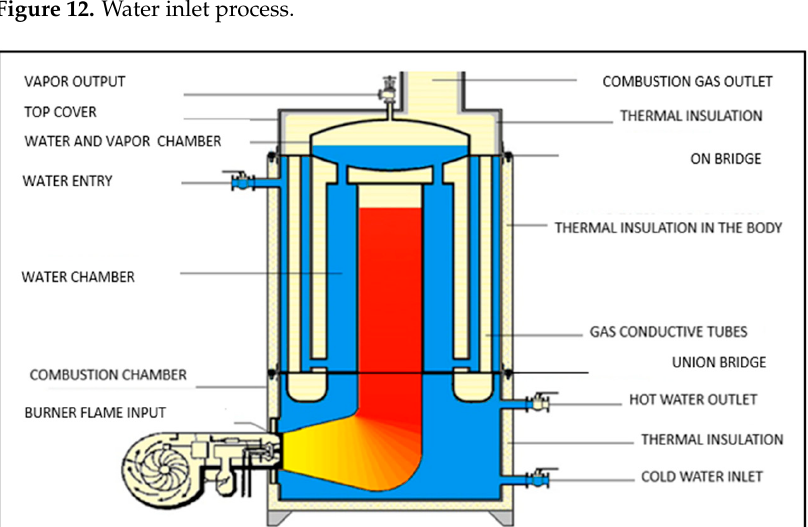
Figure 12. Water inlet process.